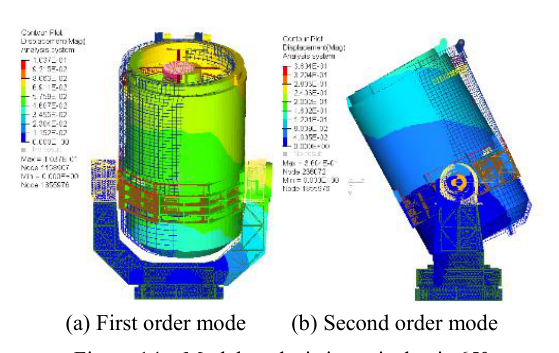
Figure 11 Finite element analysis for mirror shapr error